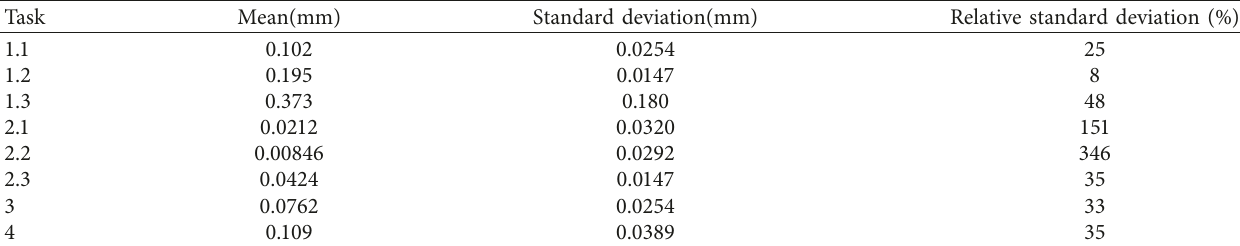
Table 8: Statistical analysis of ε